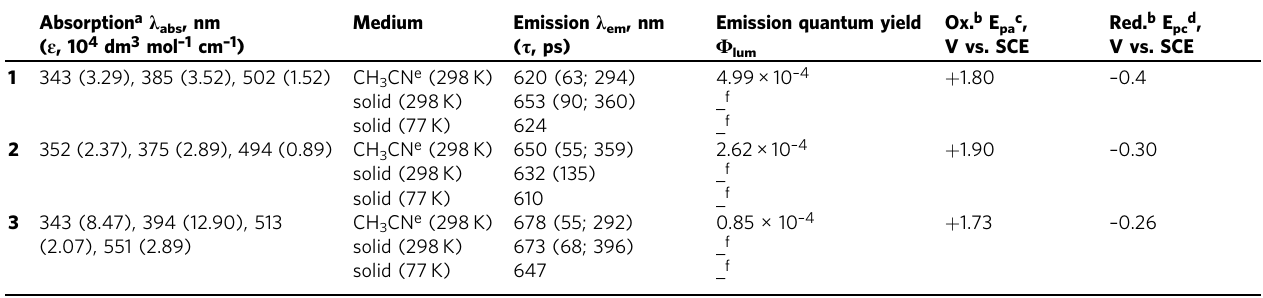
Table 1 Photophysical and electrochemical data of 1 – 3.